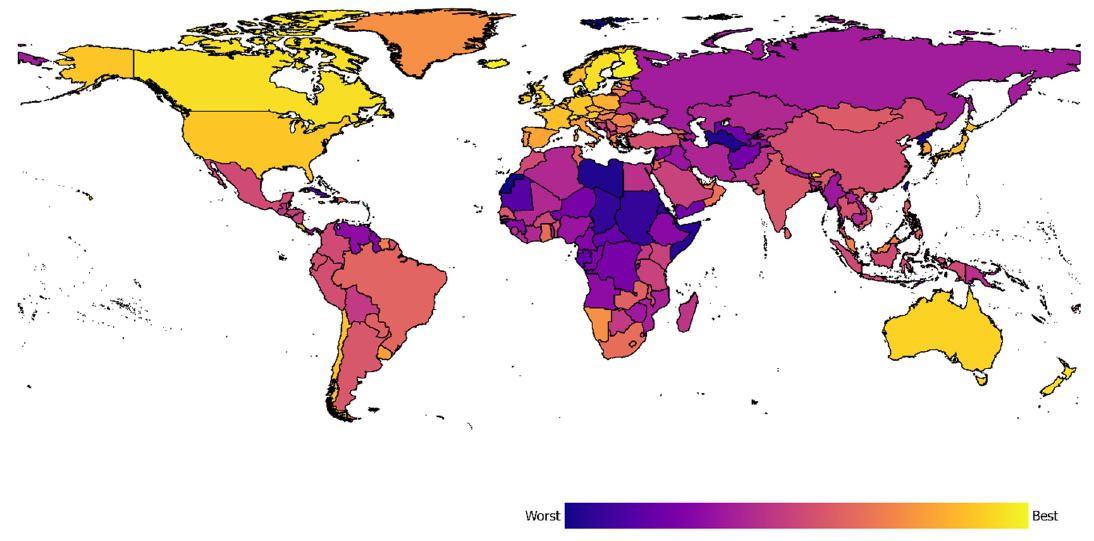
Figure 15. Global view on the policy dimension.